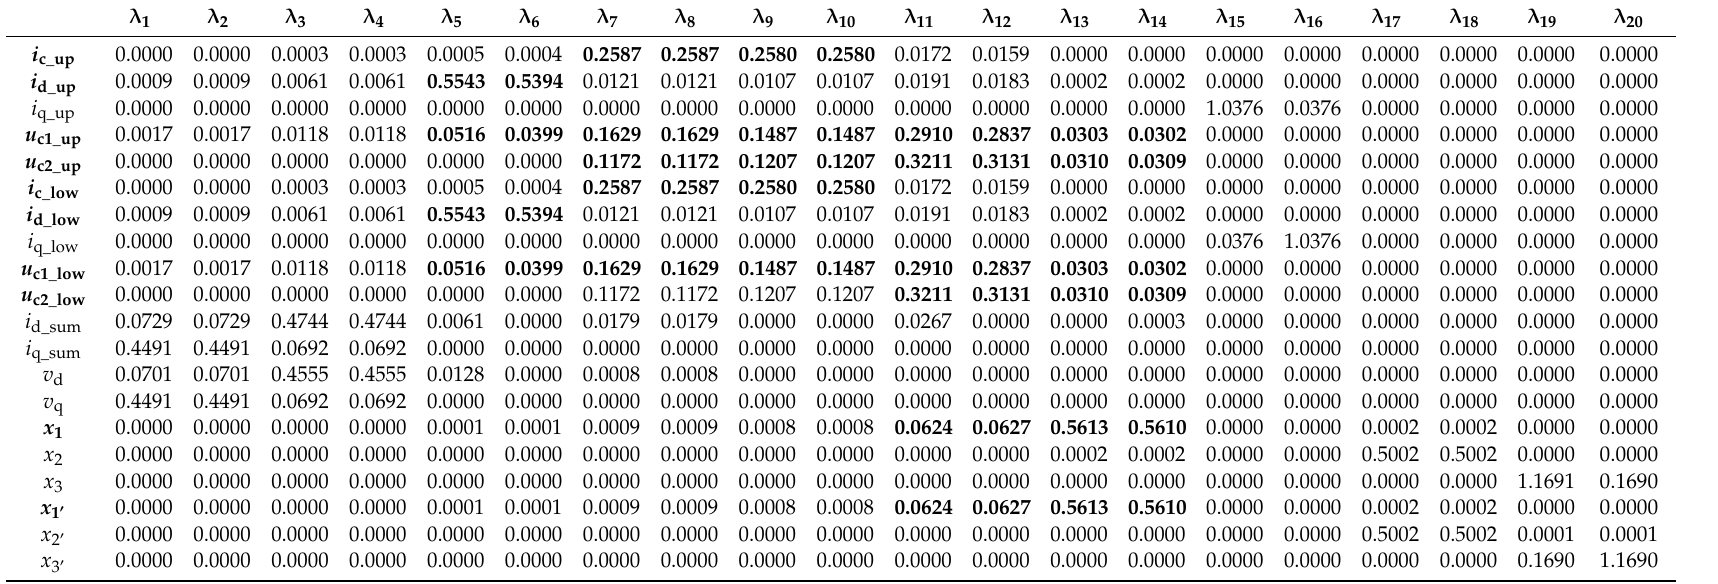
Table A1. Participation factor value of